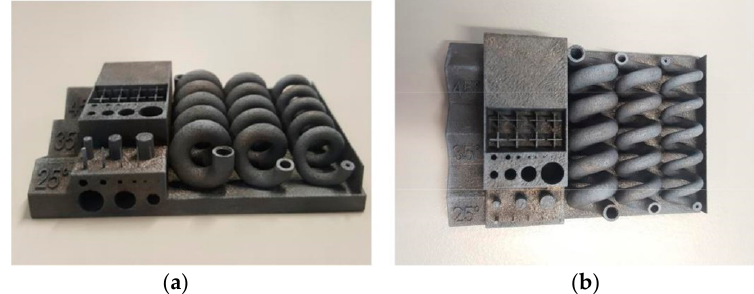
Figure 6. Views of samples received from company B. ( a ) front view, ( b ) top view.